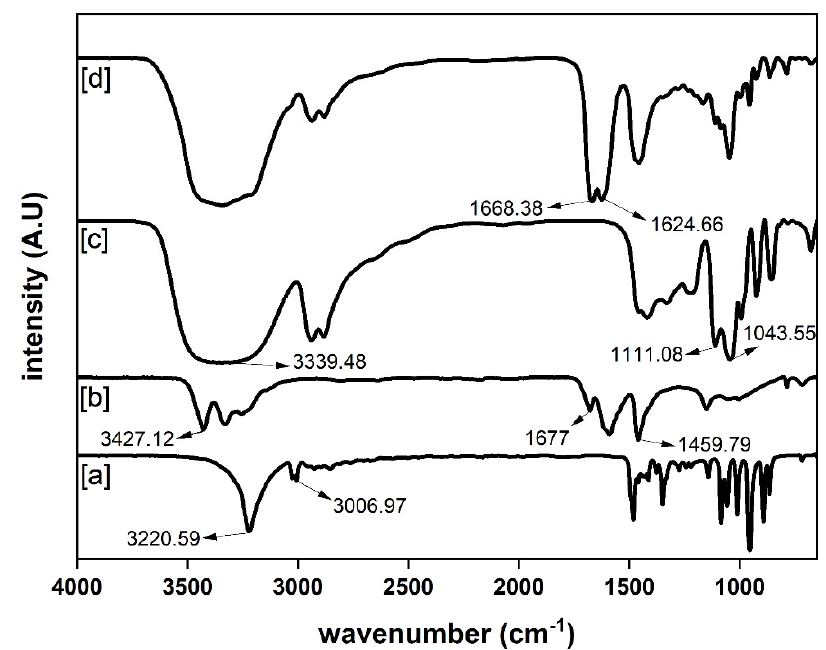
Figure 2. FTIR spectra of: ( a ) choline chloride, ( b ) urea, ( c ) glycerol, and ( d ) DES (choline chlo- ride/urea/glycerol in the ratio of 1:1:1).